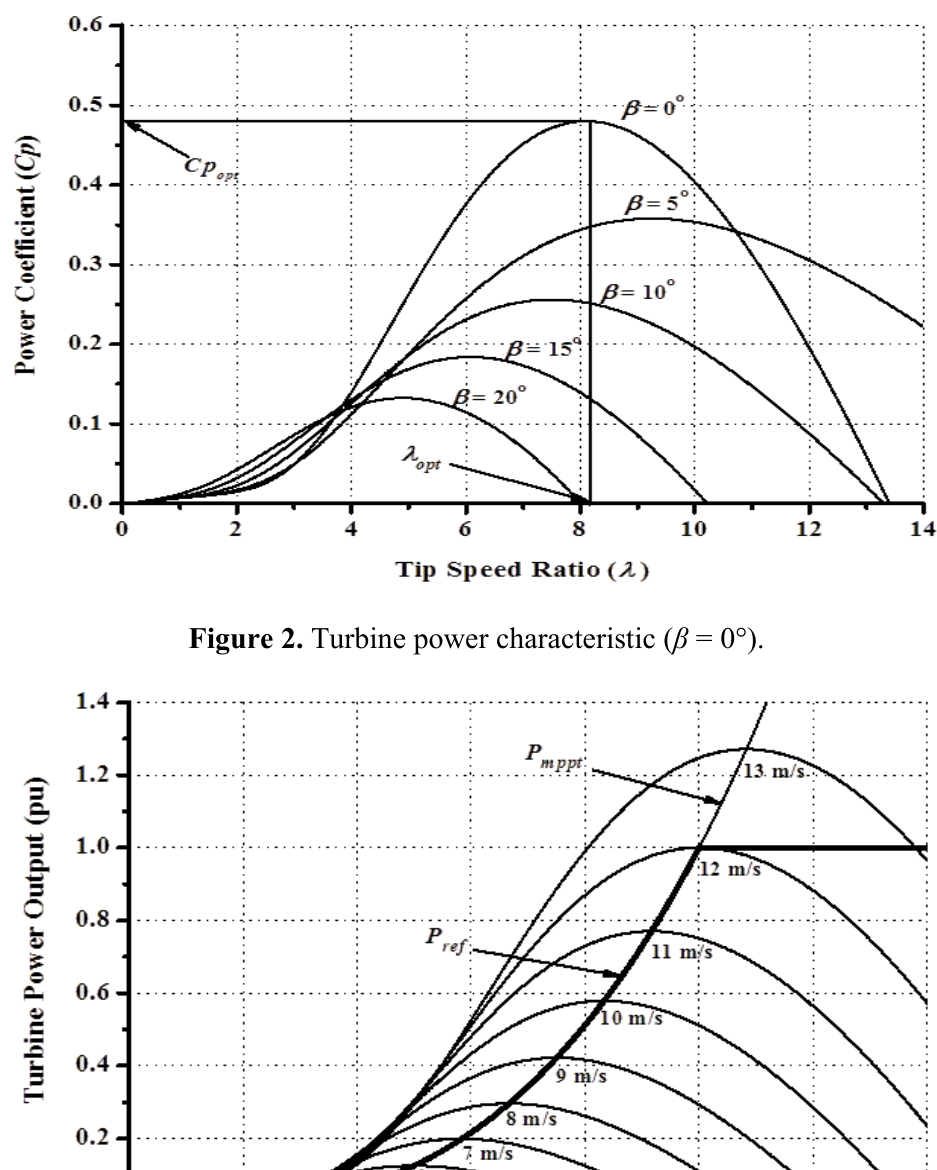
Figure 1. Cp – λ characteristic for different pitch angle.